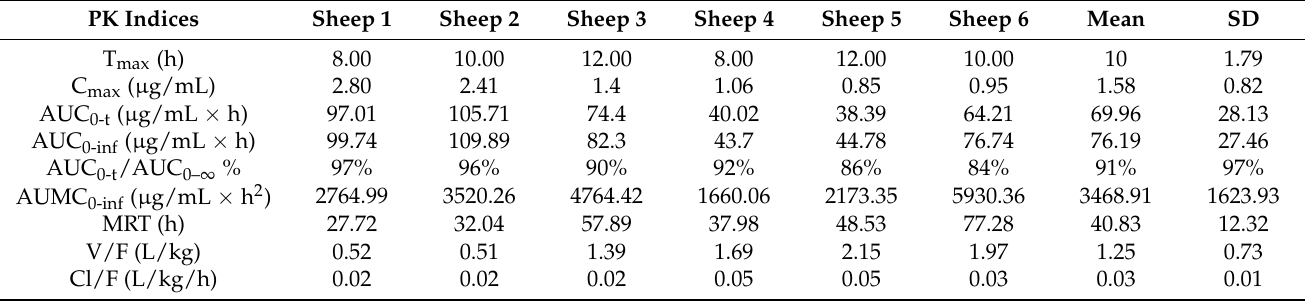
Table 1. Plasma pharmacokinetic indices following subcutaneous administration of 2 mg/kg sustained-release meloxicam formulation (SRMF) in sheep ( n =